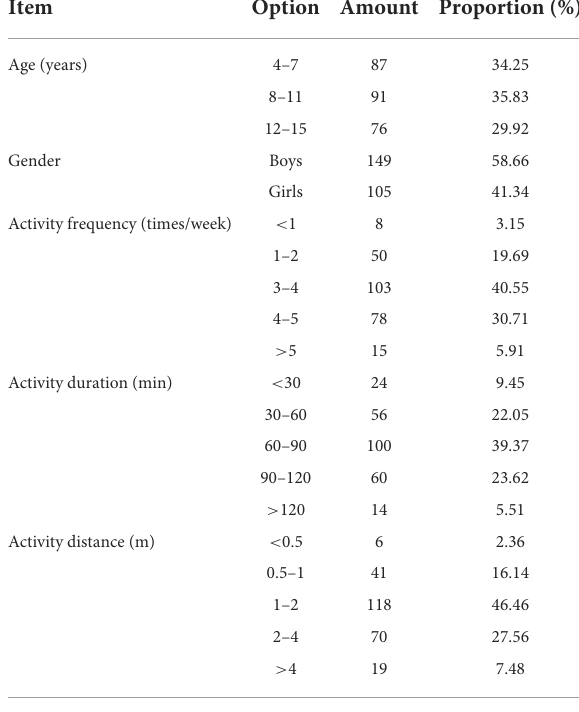
TABLE 1 Description of the study samples.